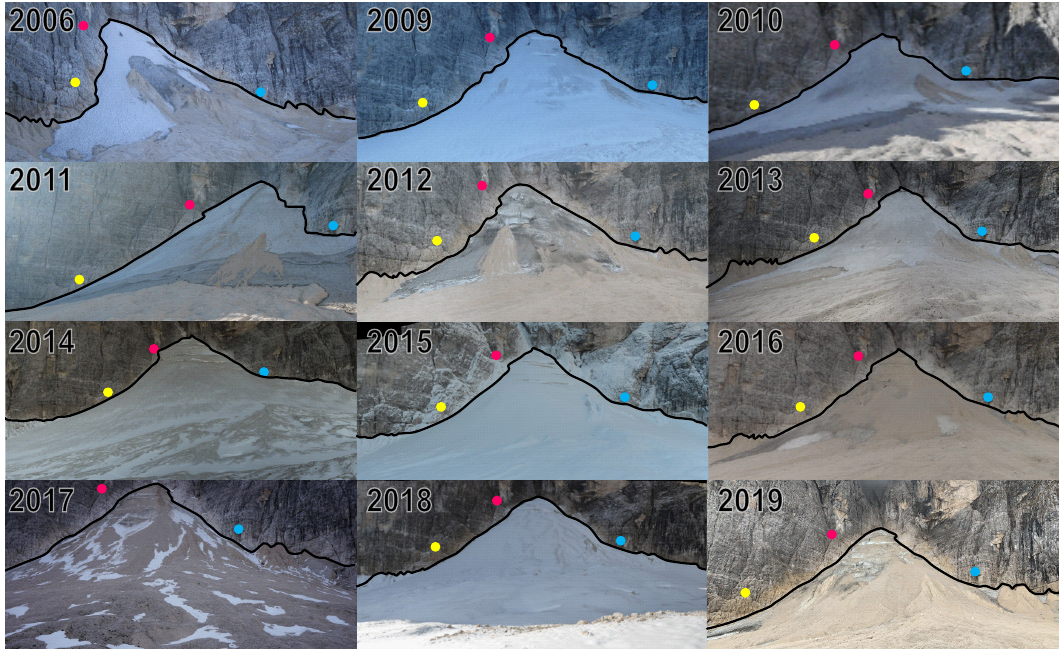
Figure 2. Photos of the Montasio Glacier taken from 2006 to 2019 at the end of the ablation season. Colored dots indicate reference points visible on the rock walls; the black line indicates the upper edge of the